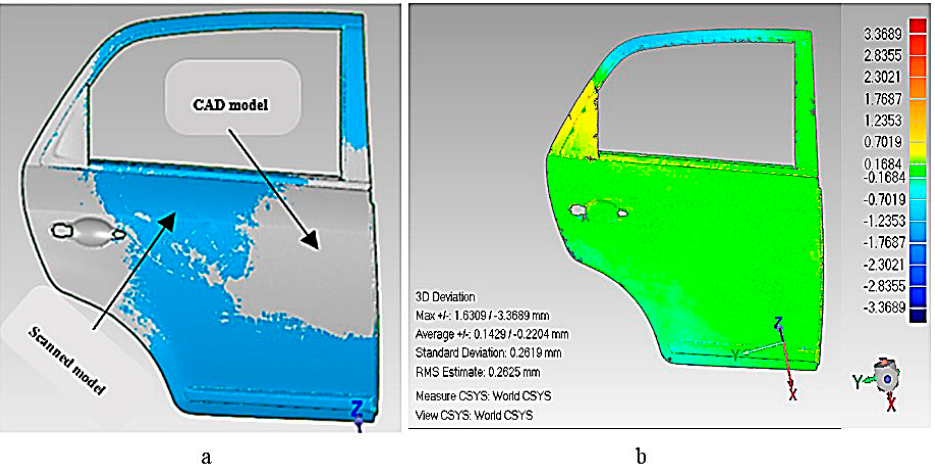
Figure 7. Measurement of accuracy using a 3D comparison ( a ) best fit of scanned and CAD models ( b ) 3D comparison results.